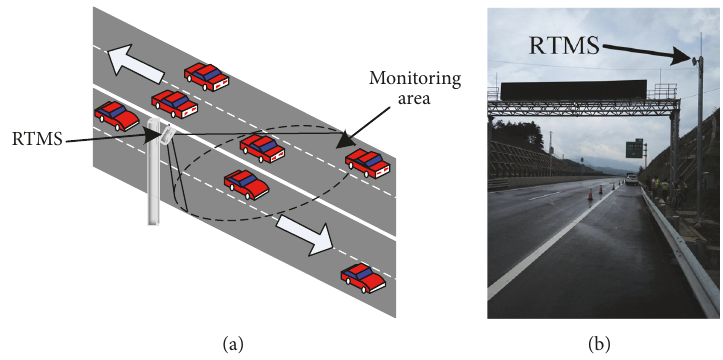
Figure 2: Remote transportation microwave sensor. (a) Detection principle. (b) Field application.